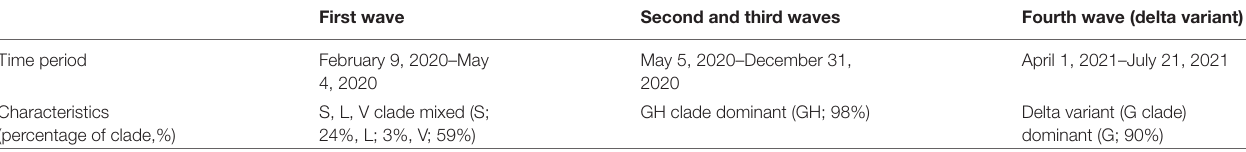
TABLE 1 | Details of different wave periods analyzed in this study and the virus clades dominant during each period. First wave